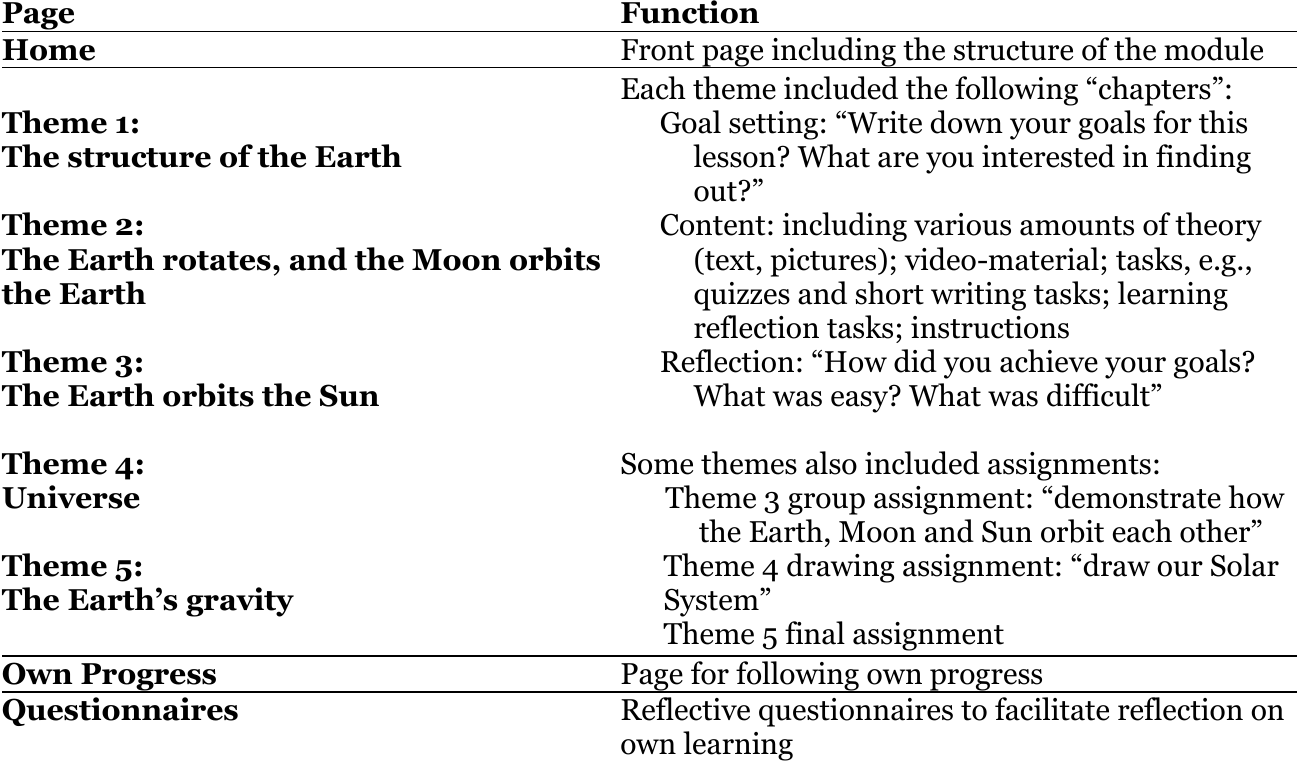
Table 1 Structure of the Space study module Page Function